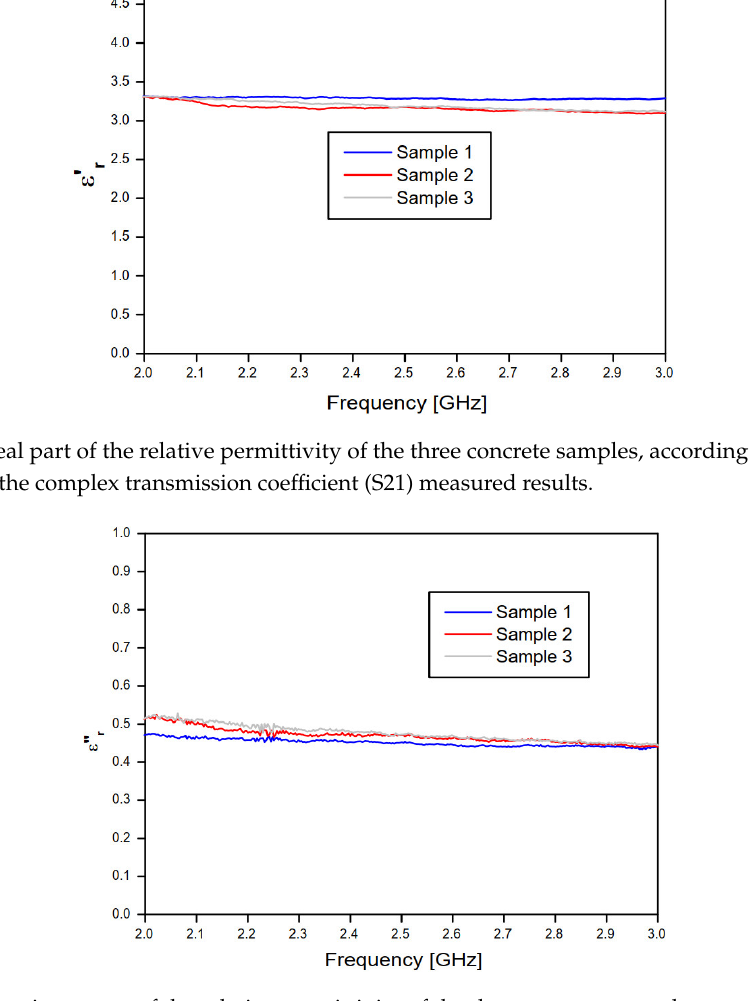
Figure 11. Imaginary part of the relative permittivity of the three concrete samples, according to the NRW method and the complex transmission coefficient (S21) measured results.